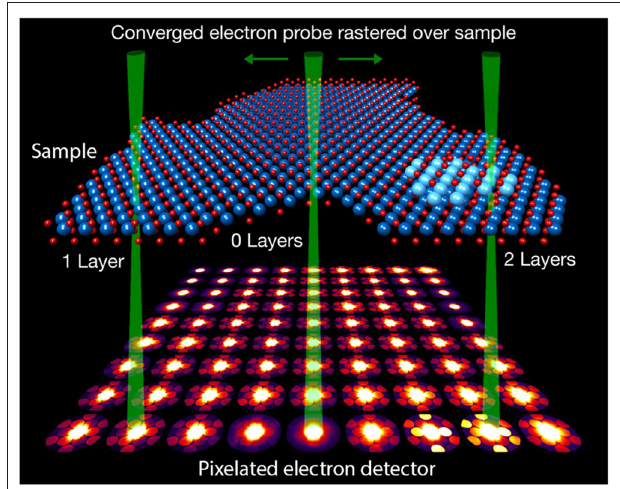
FIGURE 5 | Experimental 4D-STEM measurement of a dichalcogenide 2D material. Atomic map is inferred from the data, each diffraction pattern represents an average of 7 × 7 experimental images, green STEM probes are labeled for regions of the sample with one layer, vacuum, and two layers (Ophus,